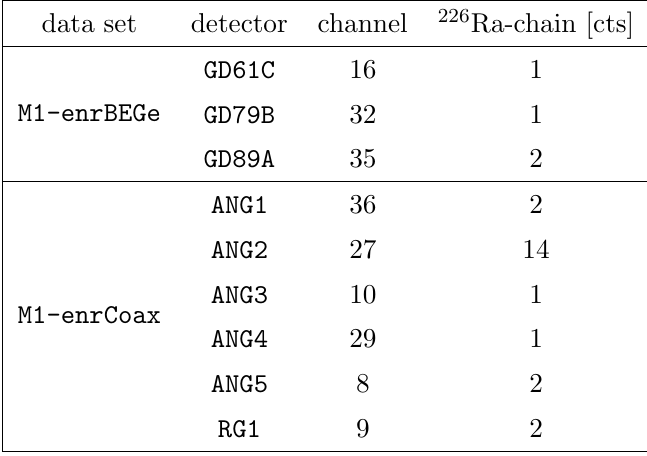
Table 7. Observed number of counts with energy > 5 : 3 MeV belonging to the 226 Ra decay chain. Detectors with zero counts are not